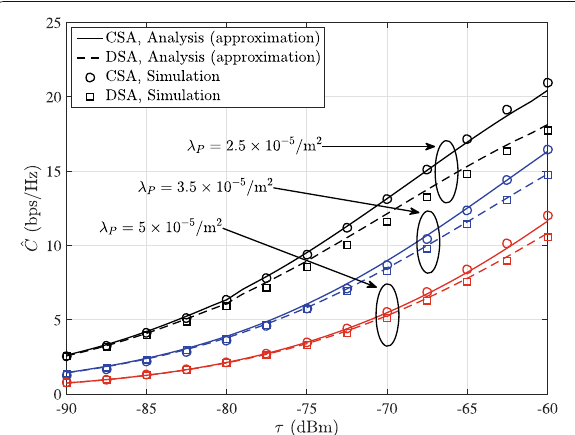
alleviate the inferences at the PBSs is considered.